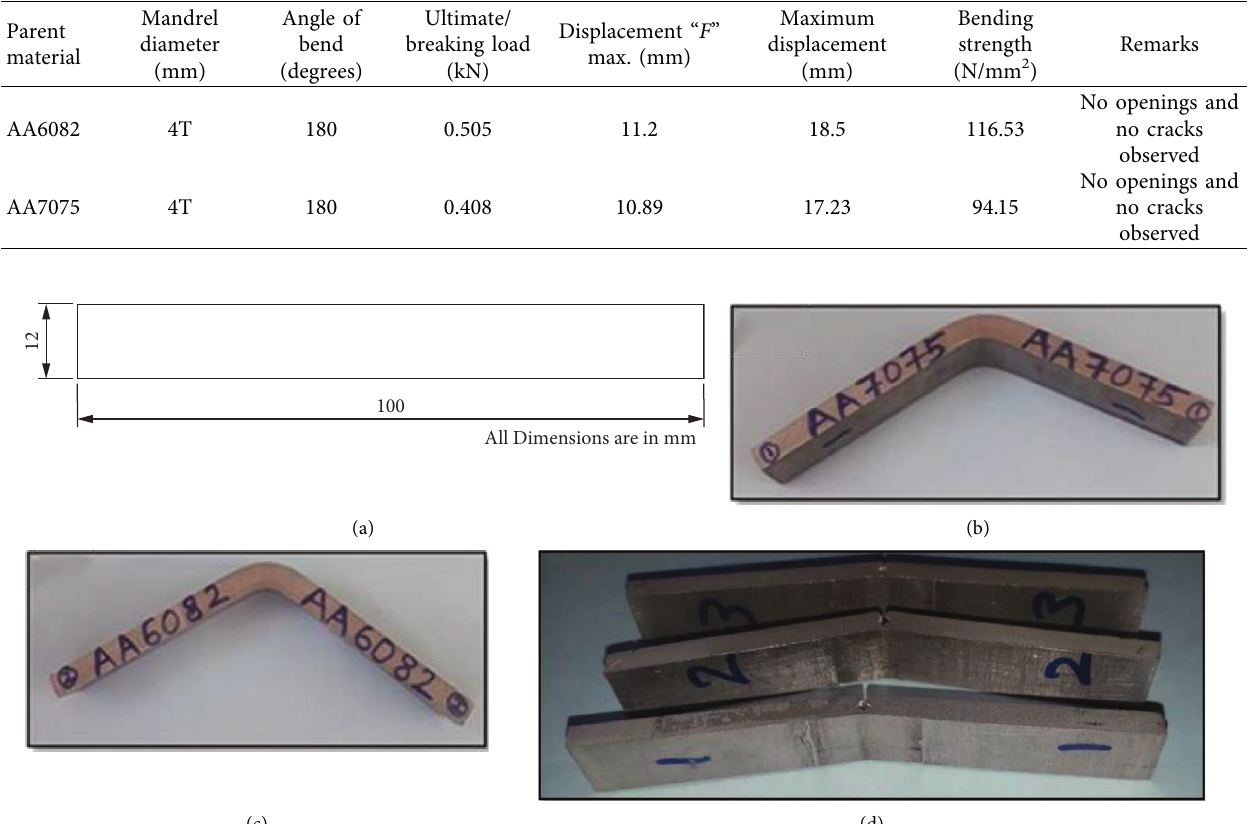
Table 7: Bending strength of the base